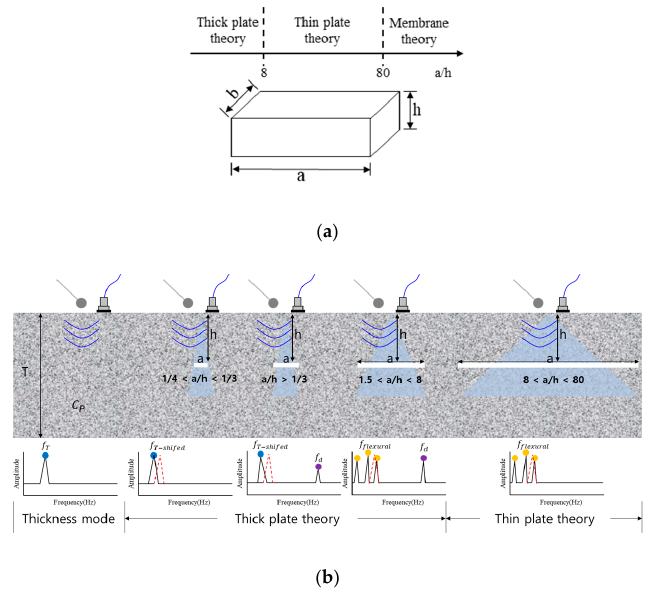
Figure 2. Criteria governing thick plate, thin plate, and membrane cases based on the side-to-thickness ratio a / h ( a > b ). ( a ) The plate theory range according to a / h ; ( b ) the tendency of thickness and flexural mode according to a / h.